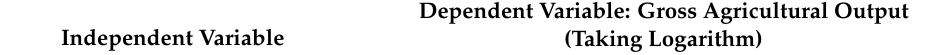
Table 4. Regression results of a production function.